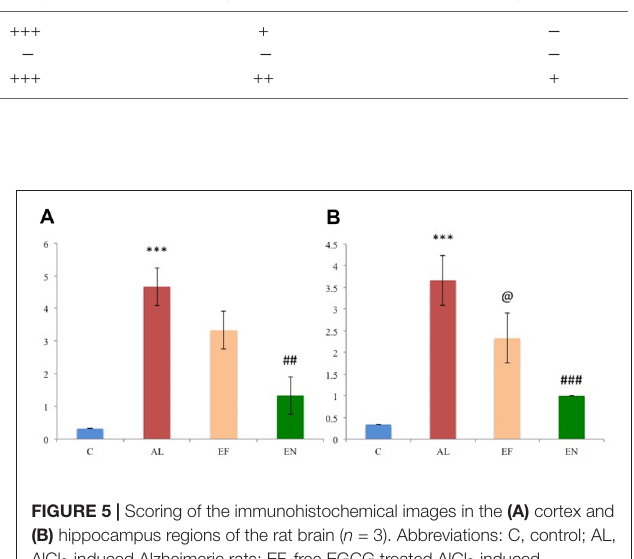
cells with occasional areas showing a neurofibrillary tangle ( Tables 1 , 2